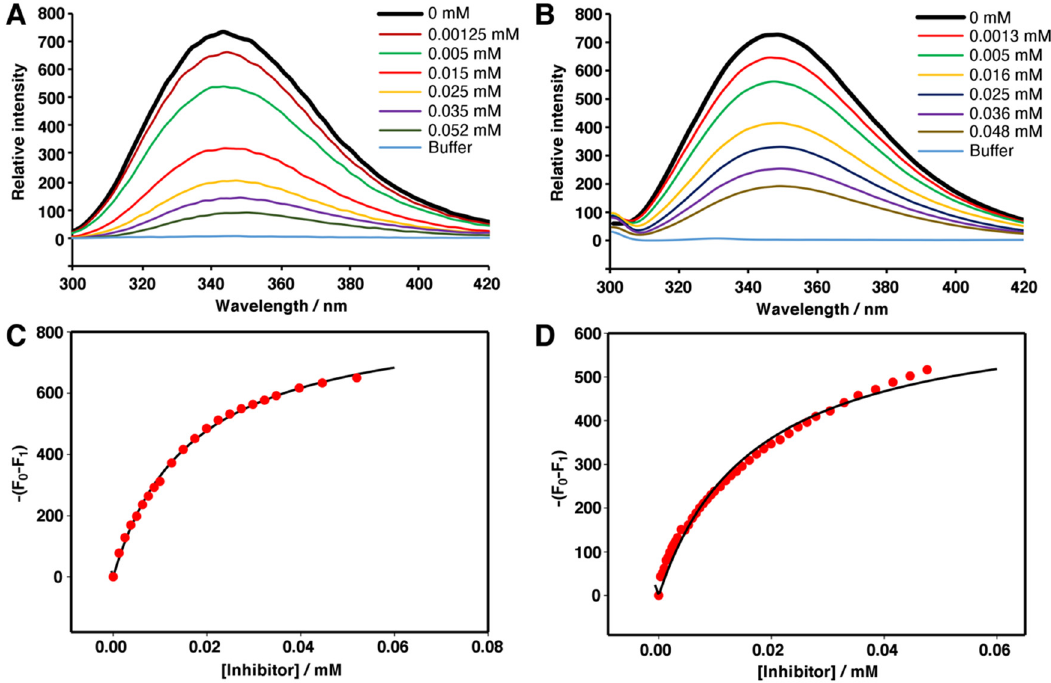
Figure 7. Fluorimetric titration of lysozyme or Slt35 with thionine acetate. Fluorescence emission of ( A ) 3 μ M Slt35 and ( B ) 2.3 μ M lysozyme in the presence of varying concentrations (indicated) of thionine acetate. Change in maximum fluorescence intensity of ( C ) lysozyme and ( D ) Slt35 with increasing thionine acetate concentration.